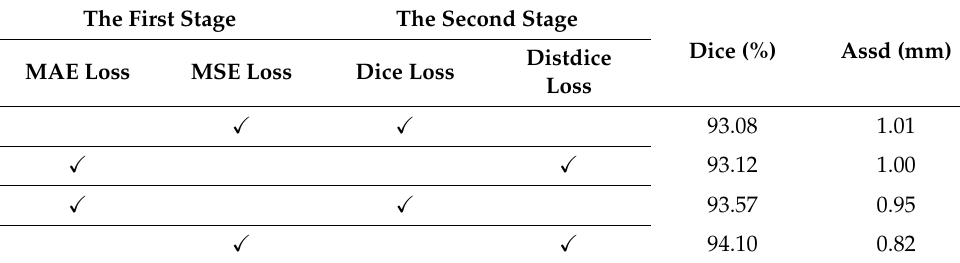
Table 3. Performance comparison experiment of loss